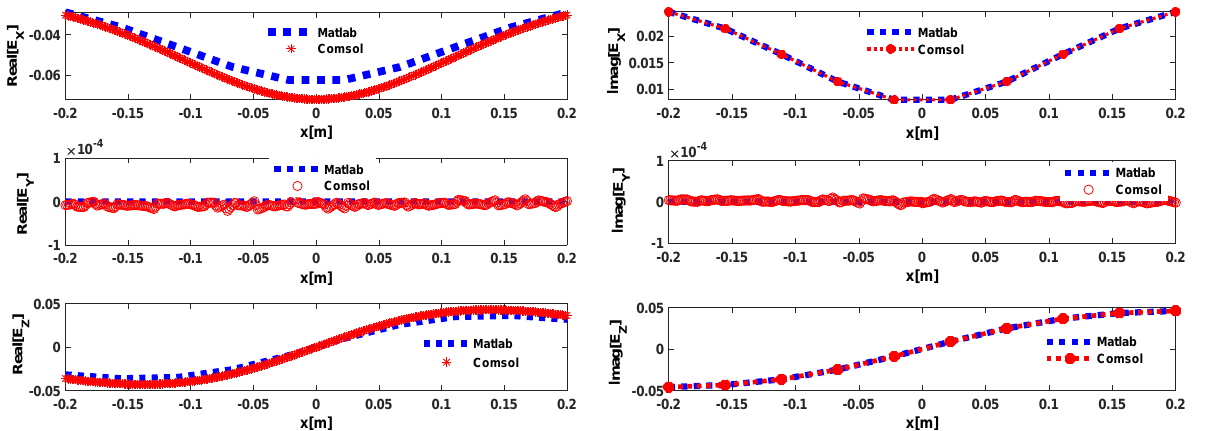
Figure 2. Real part ( left ) and imaginary part ( right ) of the scattered electric field by a PEC sphere present in free space. Matlab results (blue color dot lines) are super-imposed on Comsol results (red marker color lines). Here, selected parameters are frequency f = 0.3 GHz, radius a = c = 0.1